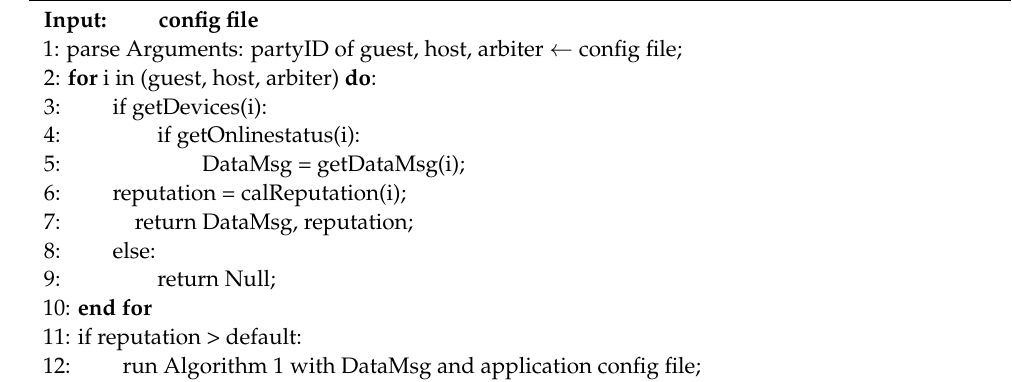
Algorithm 2 Algorithm of FL joint reputation evaluation